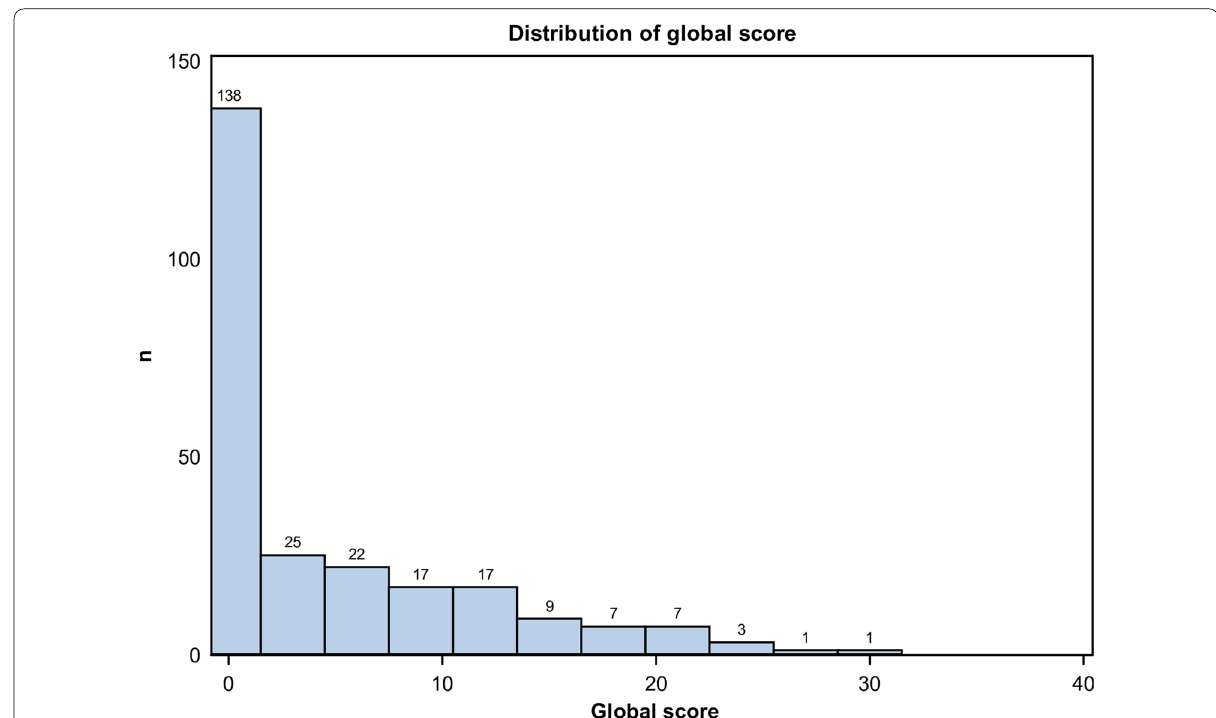
Fig. 2 Distribution of global score ranking from 0 to 40 in the 247 patients studied. Note: This was a paucisymptomatic population, and the majority of patients had a score lower than or equal to